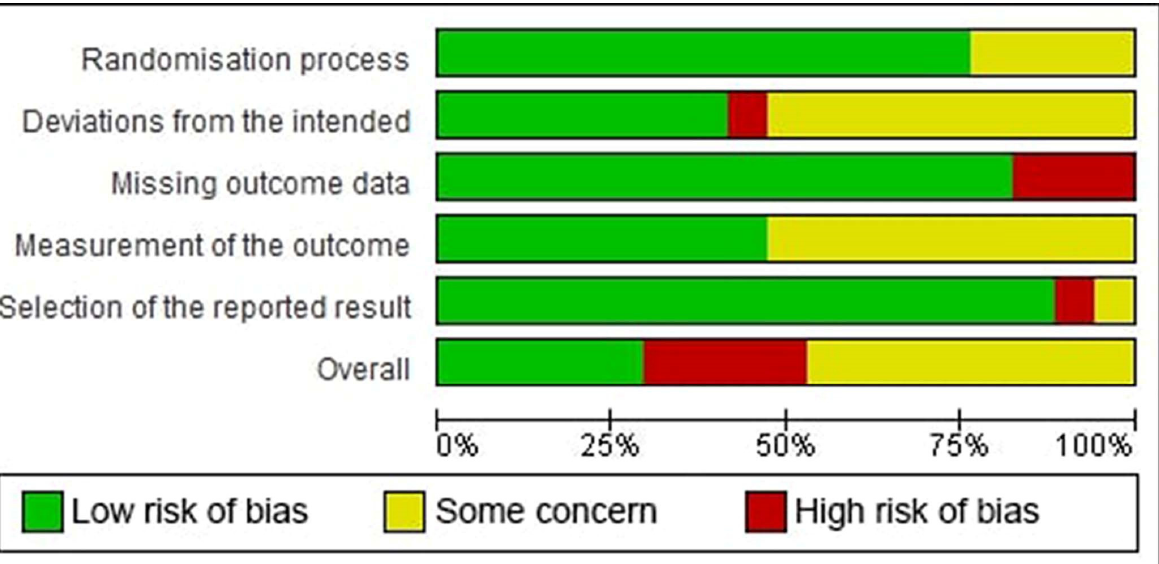
12 of 22 Table 4. Summary of meta-analysis comparing antihypertensive agents Outcome or Subgroup